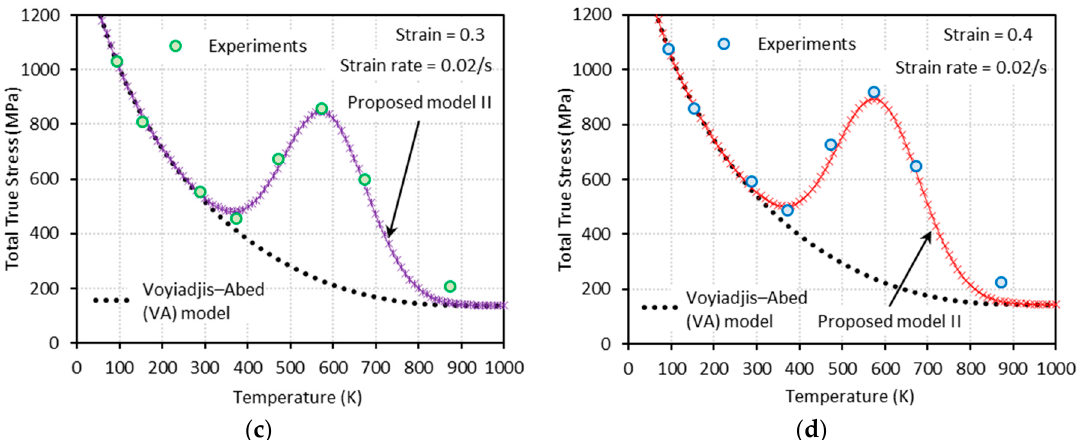
Figure 15. Comparisons between model predictions from the VA and proposed model II and experimental data from [1] on the total true stress versus temperature responses at ( a ) 𝜀 = 0.1 , ( b ) 𝜀 = 0.2 , ( c ) 𝜀 = 0.3 , and ( d ) 𝜀 = 0.4 . Quasi-static loading with 𝜀̇ = 0.02 𝑠 −1 is applied.